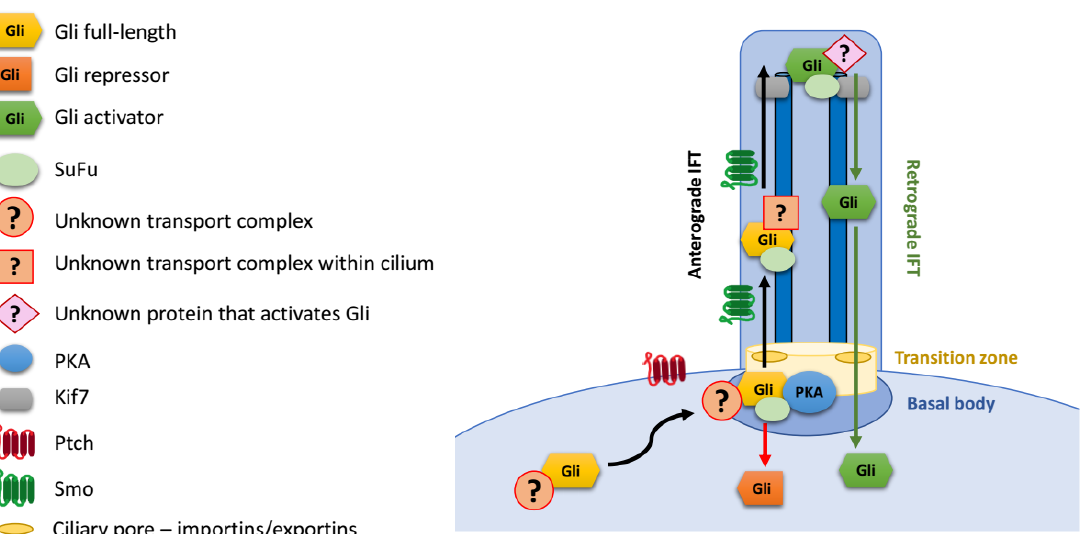
Figure 3. Gli protein transport to the primary cilium.